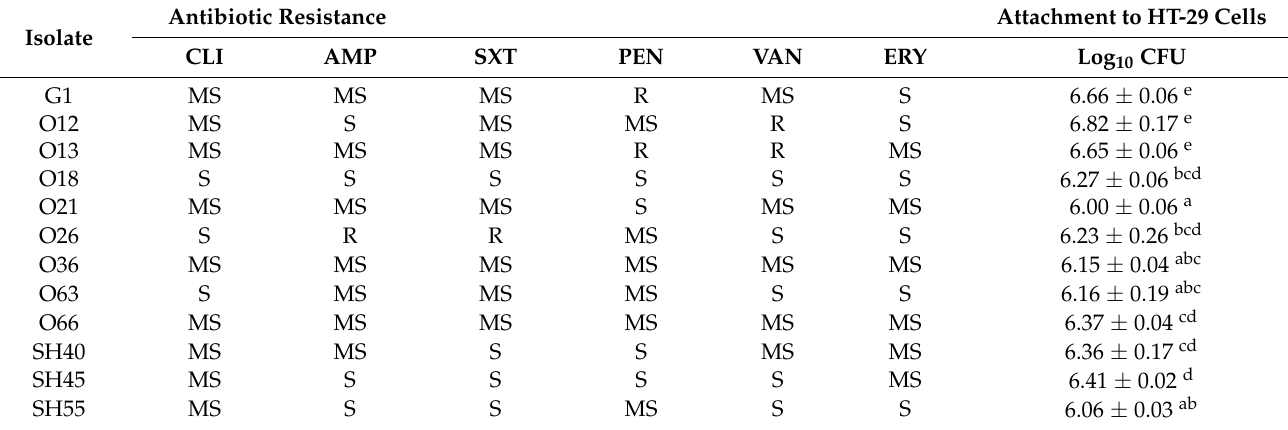
Values are expressed as mean ± standard deviation of triplicates. a CLI, clindamycin (2 µ g); AMP, ampicillin (10 µ g); SXT, trimethoprim-sulfamethoxazole (25 µ g); PEN, penicillin (10 µ g); VAN, vancomycin (30 µ g); ERY, erythromycin (15 µ g); R, resistant; MS, moderately susceptible; S, susceptible. a–e Means in same column with different lowercase letters differed significantly ( p < 0.05).